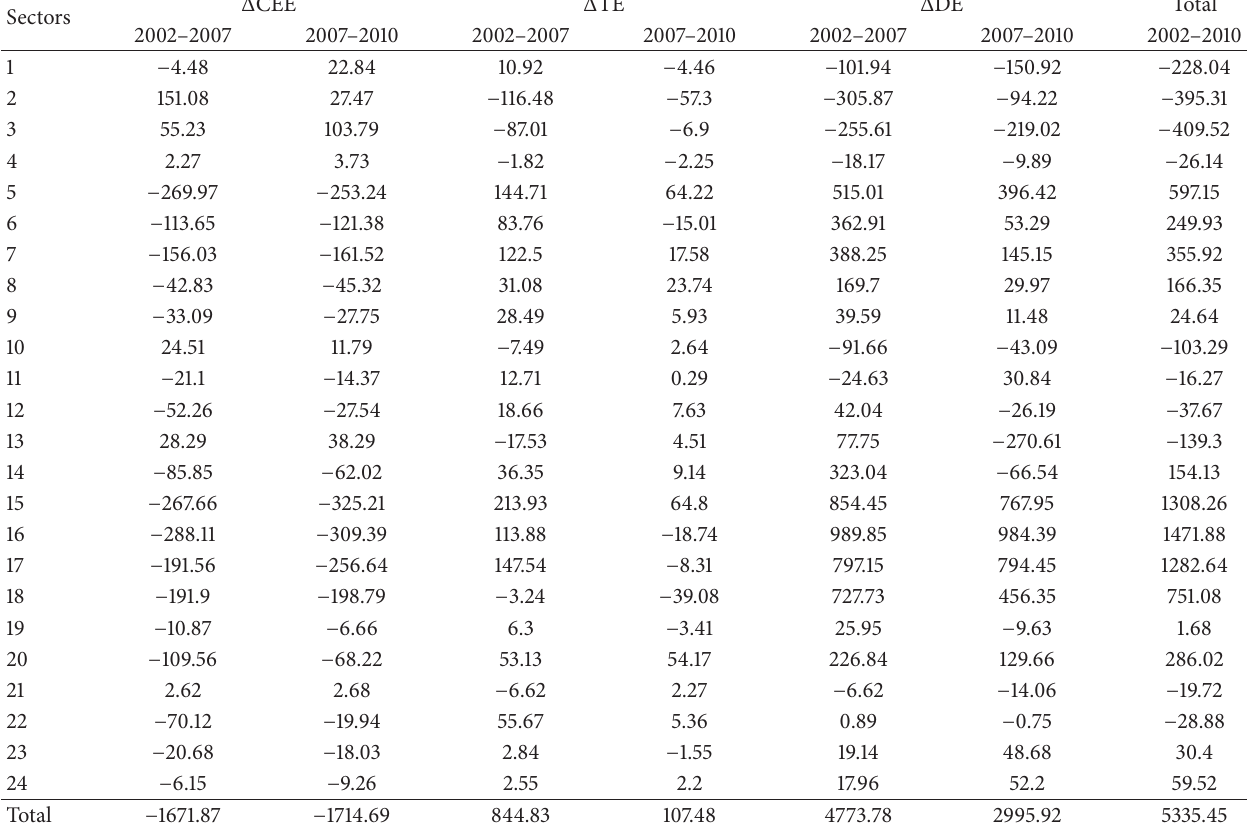
Table 4: The contribution of CEE, TE, and DE to the changes of total carbon emissions in China’s industrial